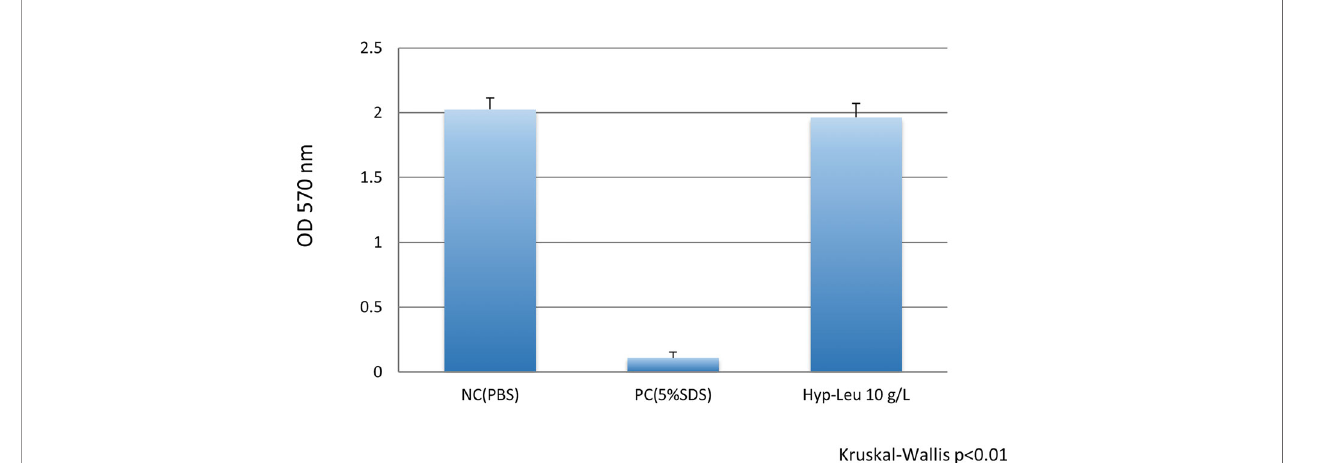
FIGURE 7 | Epithelial tissue toxicity of cyclo (Hyp-Leu). The vertical axis shows the tissue activity level deduced form the result of the MTT assay. NC (negative control, PBS) showed no irritation, and PC (positive control, 5%SDS) showed toxicity. The level of the experimental cyclo (Hyp-Leu) group was almost the same as the NC group and signi fi cantly different from the PC